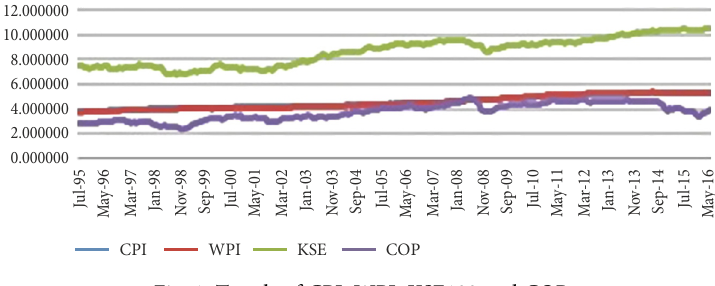
Fig. 1. Trends of CPI, WPI, KSE100 and COP Source: Authors’